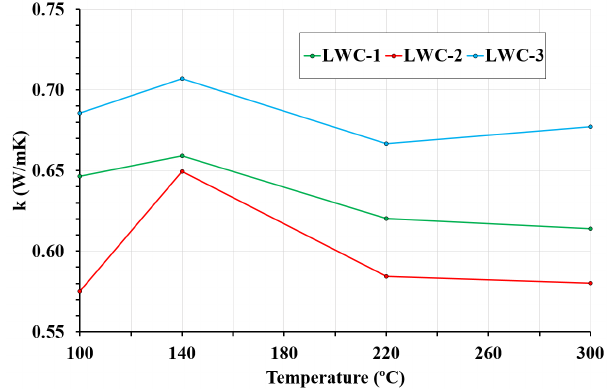
Figure 5. Thermal conductivities for all LWC types.